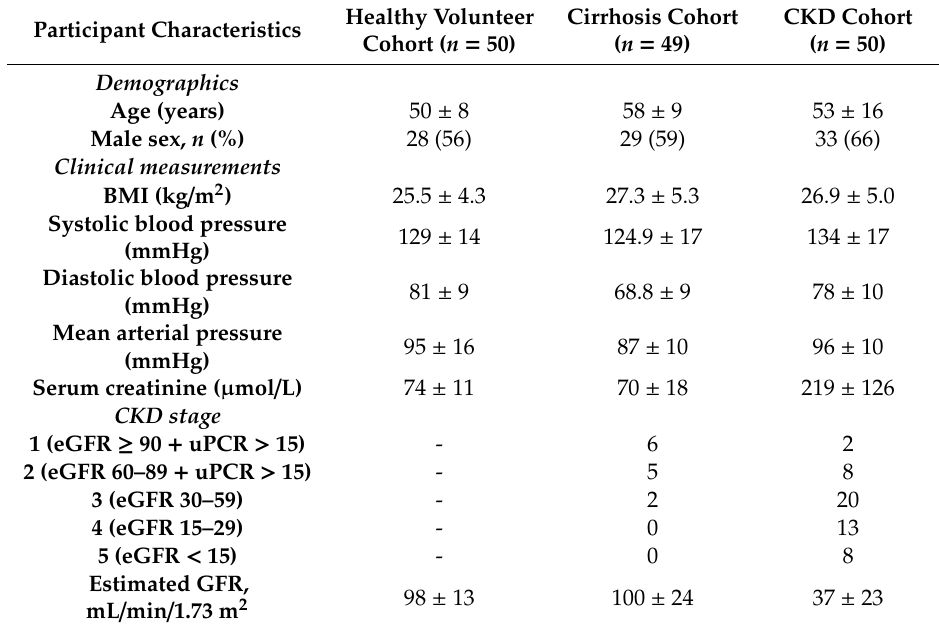
Table 1. Participant